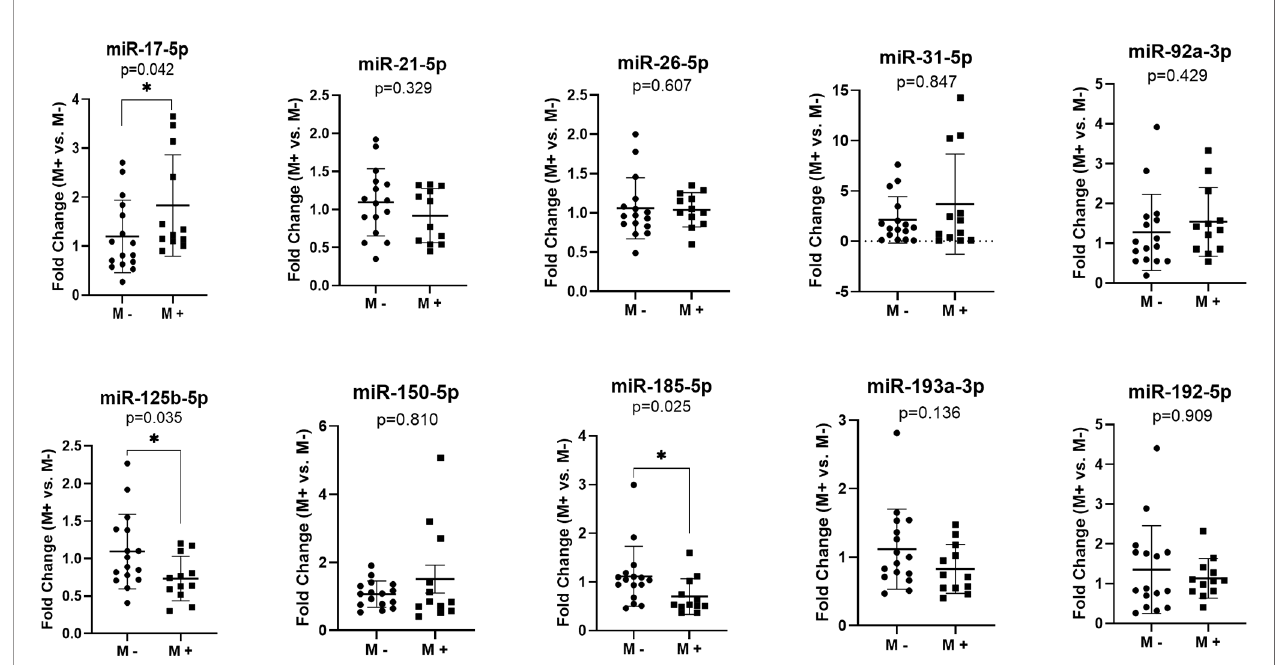
FIGURE 1 | MicroRNAs expression in the primary tumor tissues of colorectal patients with liver metastases (M+) (n=12) versus patients without metastases (M-) (n=16); according to data distribution, differential expression was tested using the non-parametric Mann-Whitney U test (miR-17-5p; miR-21-5p; miR-26-5p; miR-31- 5p; miR-92a-3p; miR-150-5p; miR-185-5p; miR-193a-3p; miR-192-5p) or parametric unpaired sample t-test (miR-125b-5p). Fold change for each sample was calculated relative to M- group. *p ≤ 0.05.